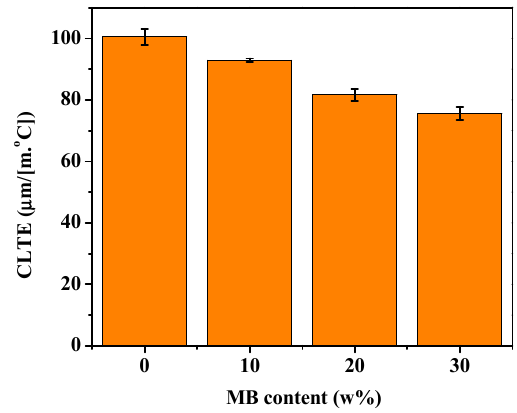
Figure 8. CLTE of the PHBV and PHBV/MB composites.